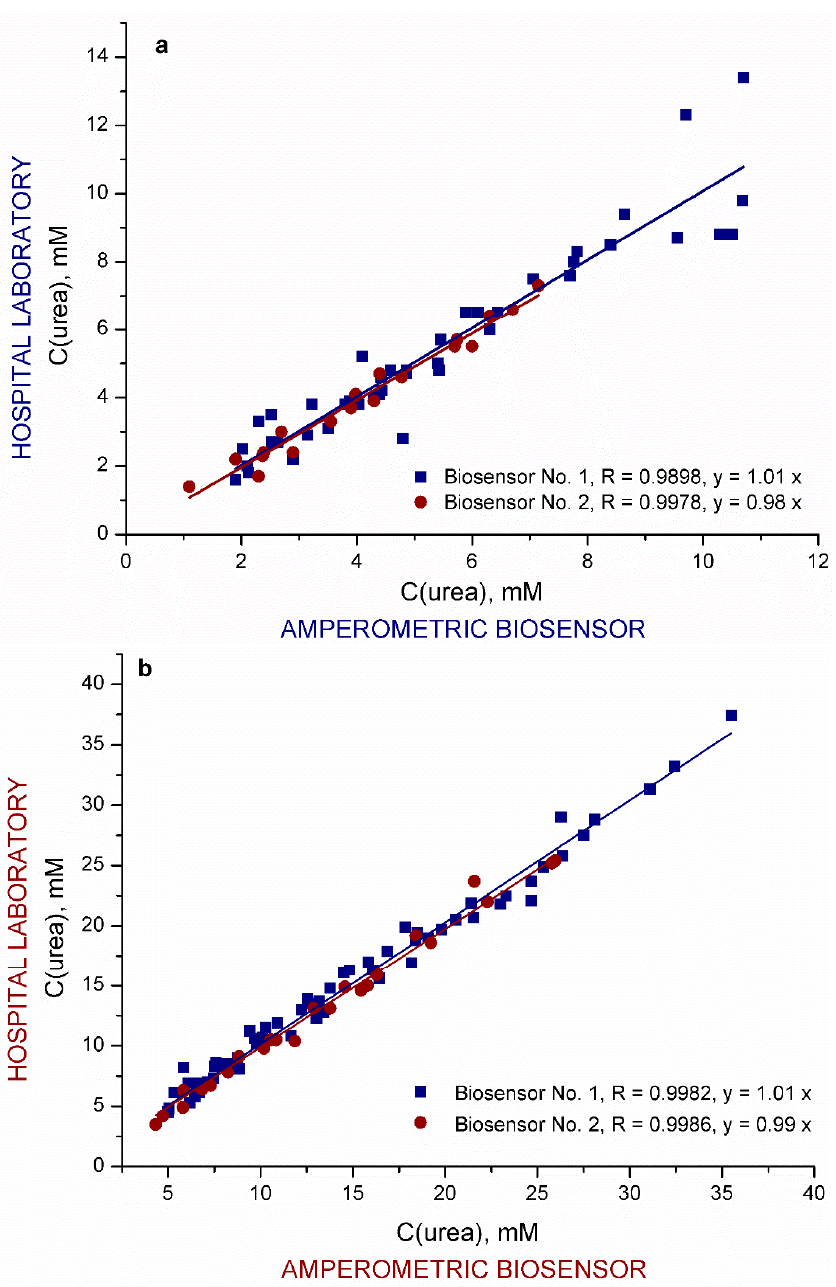
Figure 6. Correlation between urea concentrations obtained in dialysate ( a ) and blood ( b ) using amperometric TRGO-based urea biosensors and in a controlled hospital